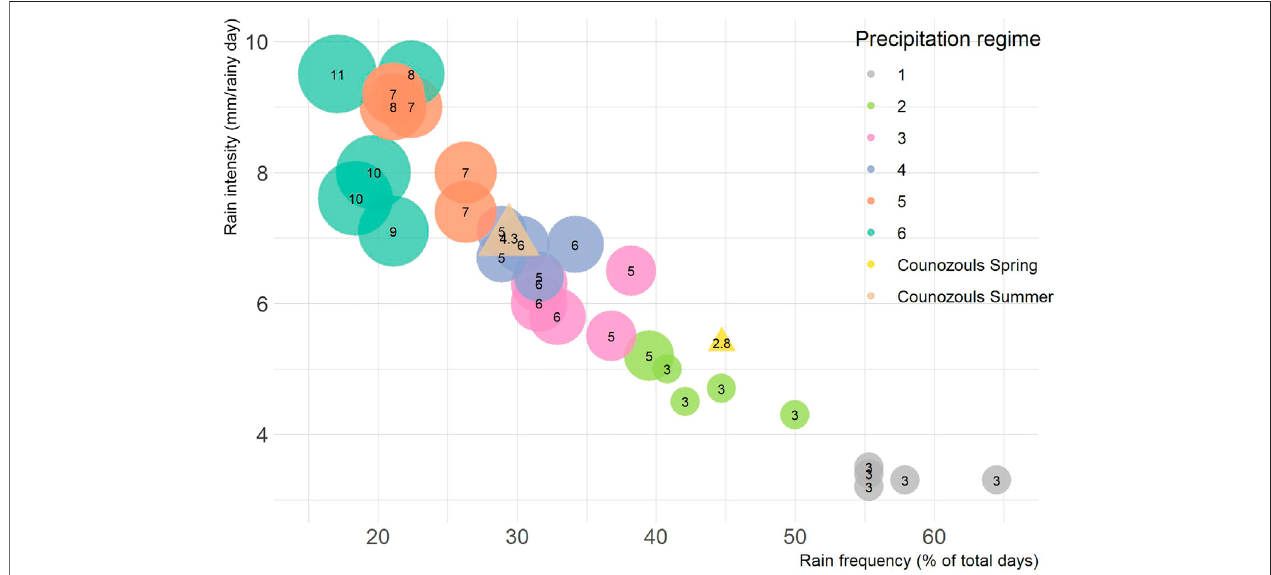
FIGURE 1 | Characteristics of rainfall patterns to which the mesocosms (circles) were exposed during the resistance phase, along with those observed at the reference site Counozouls (triangles) during spring and summer 2019. Experimental rainfall treatments fell into one of six precipitation regimes of reducing rainfall frequency but increasing intensity. Size of the bubbles is scaled to drought intensity, given as the average number of days between rainfall